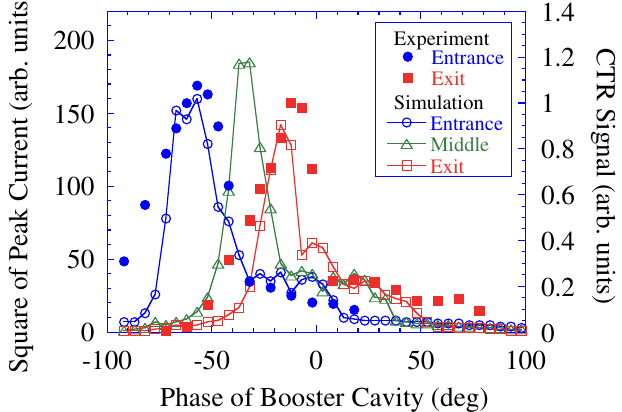
FIG. 7. (Color) Comparison between the measured (filled sym- bols, f > 3 : 75 GHz ) dependence of the CTR intensity on rf phase of the booster cavity and the simulated (open symbols) dependence of the peak current. Squares of the peak current are plotted to reproduce the measured CTR peak shapes. The circles, triangles, and squares represent the entrance, middle, and exit of the APS,